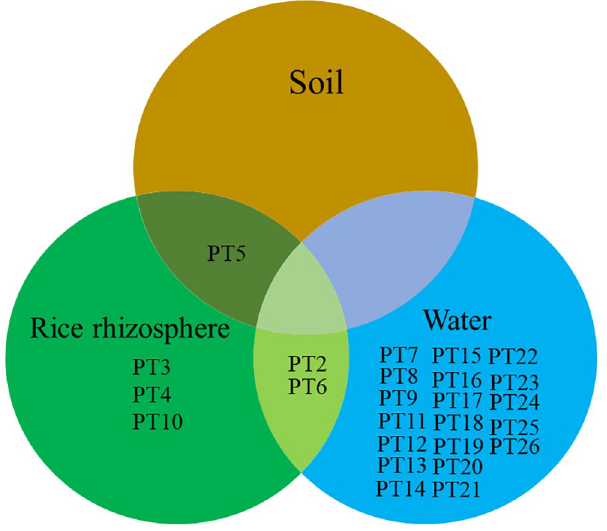
Fig 6. Venn diagram of 25 representative PFGE types from environmental B . pseudomallei isolates in the soil, rice rhizosphere and water samples. PT7, PT8 and PT9 were collected from the environment near the patient’s residence, whereas PT2, PT3, PT4, PT5, PT6, PT7, PT8 and PT10 to PT26 were collected from the sites to which the patient was suspected to be exposed in Buriram, Northeast